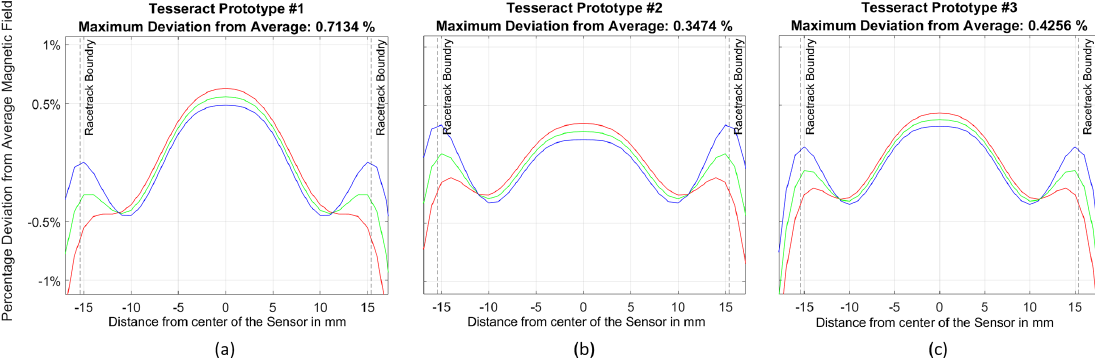
Figure 6. Homogeneity of the feedback magnetic field along the axis of the racetrack core for each axis of the three optimized sensors. The racetrack core occupies the region between the vertical dashed black lines at − 15 . 7 and 15.7mm. Configuration (b) was optimized for best homogeneity, while sensor (c) was chosen for good homogeneity with very low power consumption.